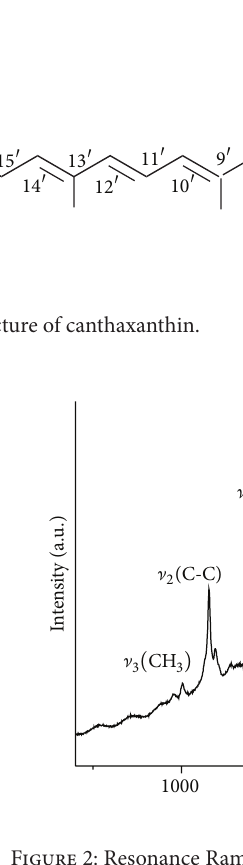
Figure 2: Resonance Raman spectrum of canthaxanthin at normal pressure.